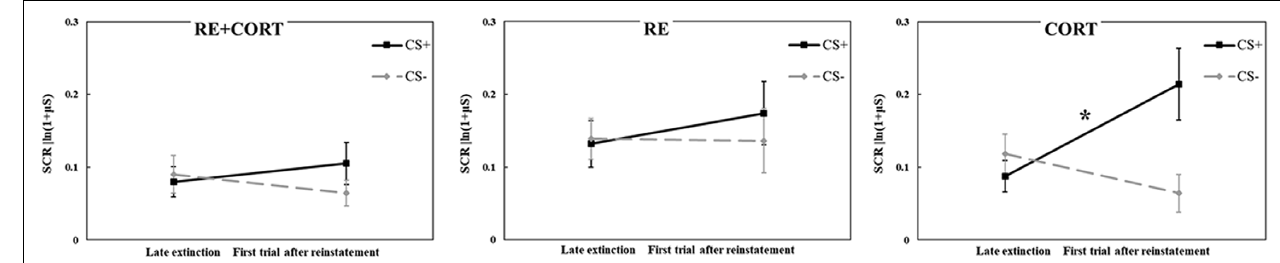
FIGURE 4 | Day 3: Analyses of the reinstatement test to the original stimuli compared the mean ( ± SEM) SCR to the conditioned stimuli (CS+, CS − ) in the late phase of extinction (mean of the last five trials; late extinction CS+: RE+CORT: 0.08 ± 0.02; RE: 0.13 ± 0.03; CORT: 0.09 ± 0.02; late extinction CS − : RE+CORT: 0.09 ± 0.03; RE: 0.14 ± 0.03; CORT: 0.12 ± 0.03) and the first trial after reinstatement (first reinstatement trial CS+: RE+CORT: 0.10 ± 0.03; RE: 0.17 ± 0.04; CORT: 0.21 ± 0.05; first reinstatement trial CS − : RE+CORT: 0.06 ± 0.02; RE: 0.14 ± 0.04; CORT: 0.06 ± 0.03) in the three experimental groups ( N = 73; RE+CORT group: n = 24, RE group: n = 25, CORT group: n = 24). In the CORT group, differential reinstatement (i.e., higher SCR after the reinstatement shocks only to CS+) was found ( ∗ p < 0.05). No reinstatement was found in the two reactivation groups, RE+CORT and RE (all p < 0.01).